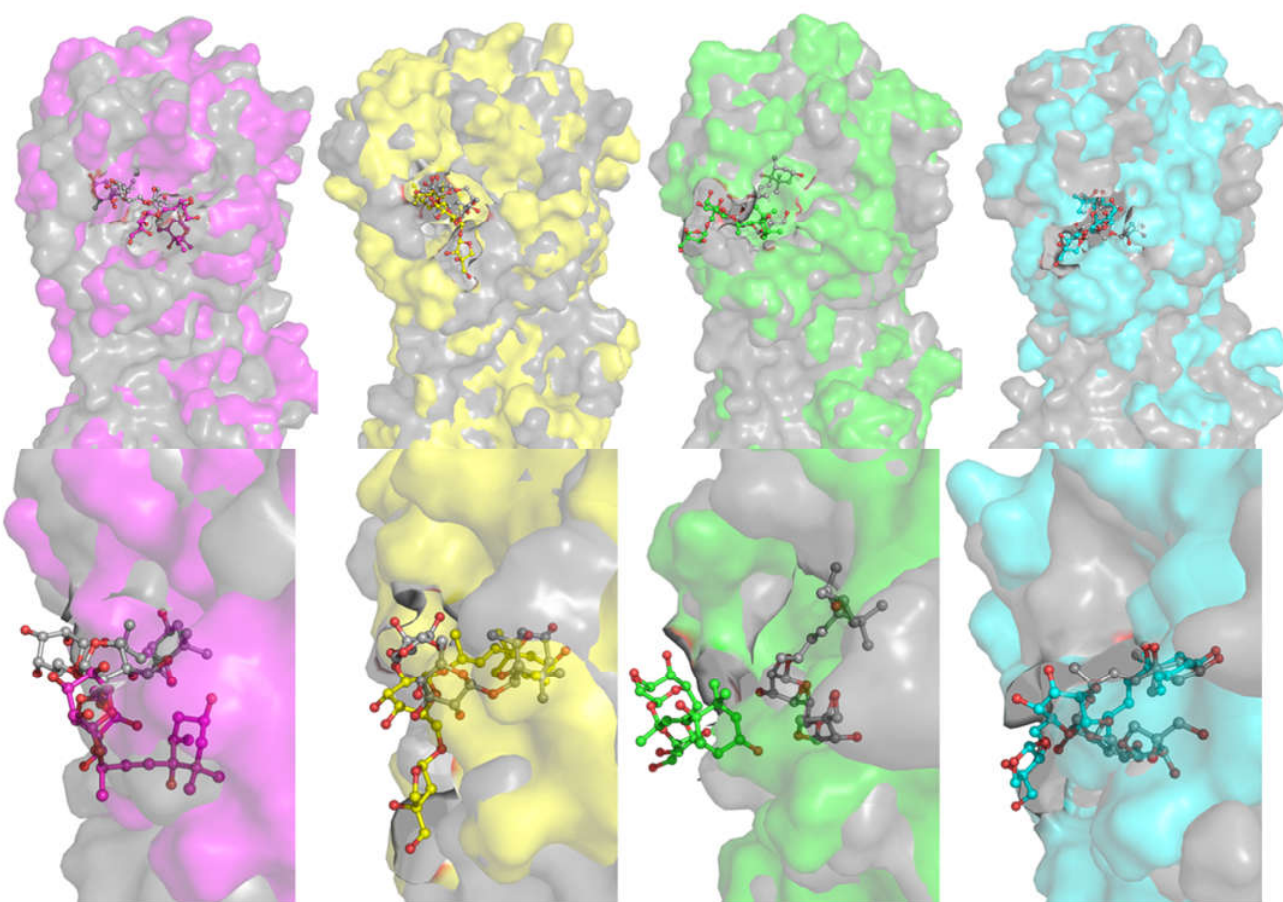
Figure 4. Superimposition of the starting and the representative structures of M pro variants in complex with the L01 and L02 compounds. The proteins are shown in transparent surface and the compounds in sticks and spheres with the following scheme color: gray: starting trajectory structures, magenta: L01 - M pro WT, yellow: L02 - M pro WT, green: L01 - M pro O, cyan: L02 - M pro O.